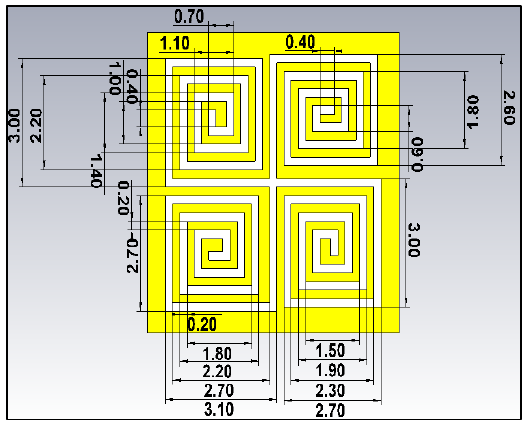
Figure 10. Designed spiral EBG unit cell.